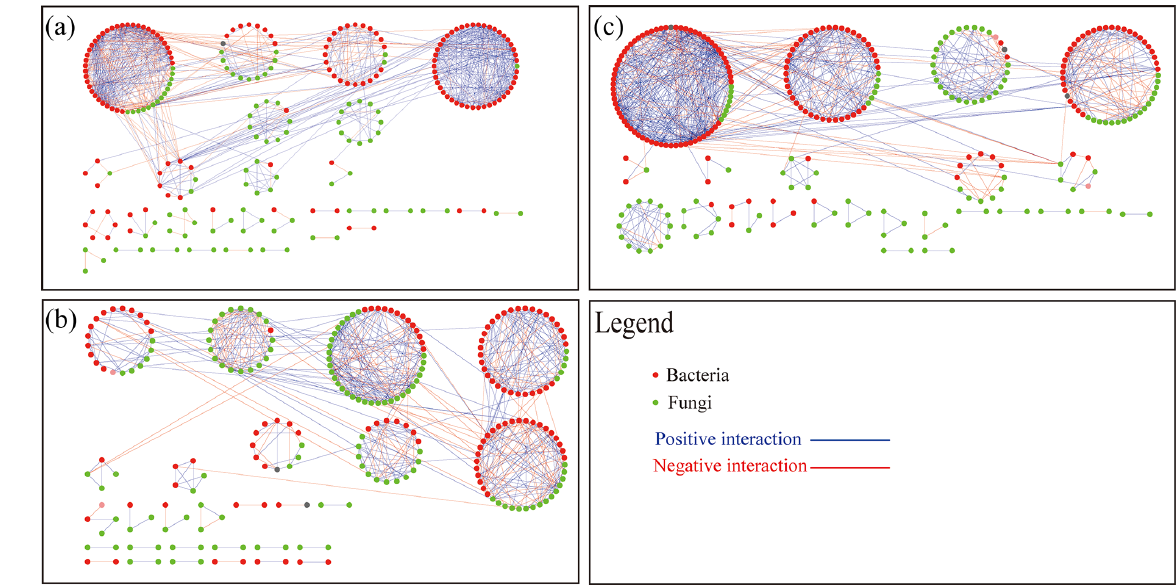
Figure 5. Network plots of bacterial and fungal communities in soil BOF (a) , PBIO (b) and POF (c) . BOF – banana continuously cropped with OF application; POF – banana–pineapple rotation with OF application in the banana season; PBIO – ,banana–pineapple rotation with BIO application in the banana season; red nodes indicate bacteria; green nodes indicate fungi; red lines between nodes (links) indicate negative interaction; and blue lines indicate positive interaction.